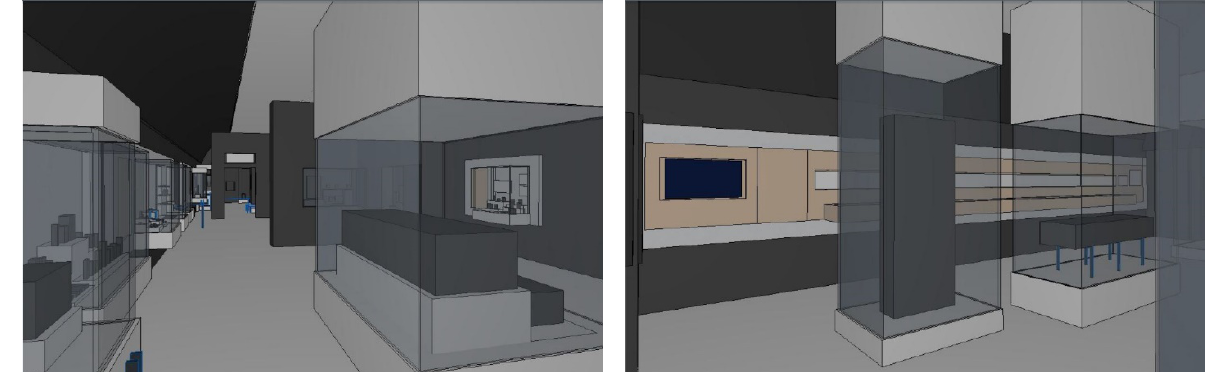
Figure 2. Two renderings of the section Afterlife from the new Egyptian Museum project